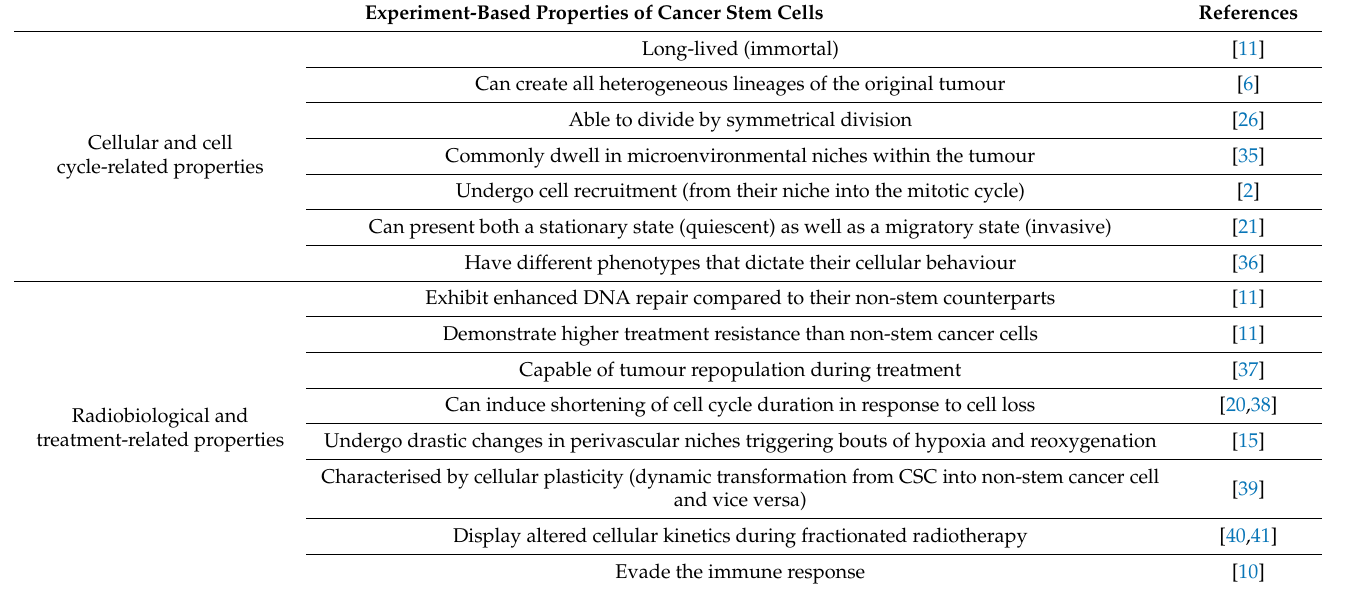
Table 1. Properties of cancer stem cells revealed by experimental